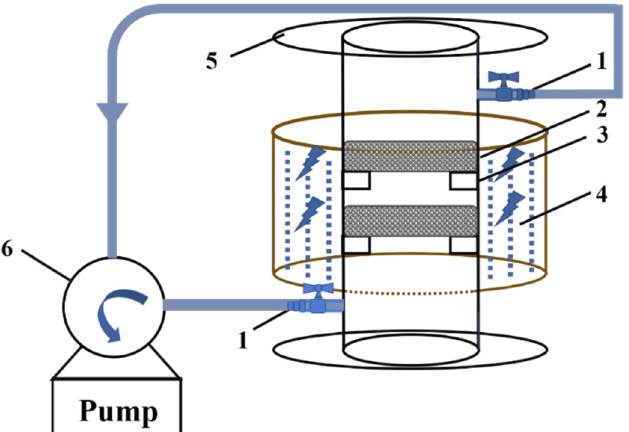
Figure 1. Schematic diagram of the photo-reactor: (1) inlet and outlet, (2) N-TiO 2 /SiC foams, (3) catalyst holder, (4) LED lights, (5) acrylic tube, and (6) peristaltic pump.